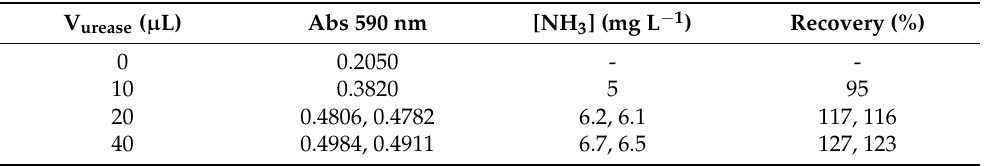
Table 2. Assayed volumes from urease solution, with absorbance at 590 nm, and equivalence to ammonia